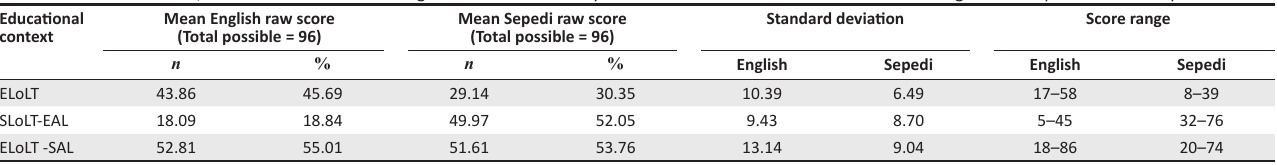
TABLE 2: Mean raw scores, standard deviations and range of scores obtained by learners in each educational context on the English and Sepedi sentence repetition tests. Educational context